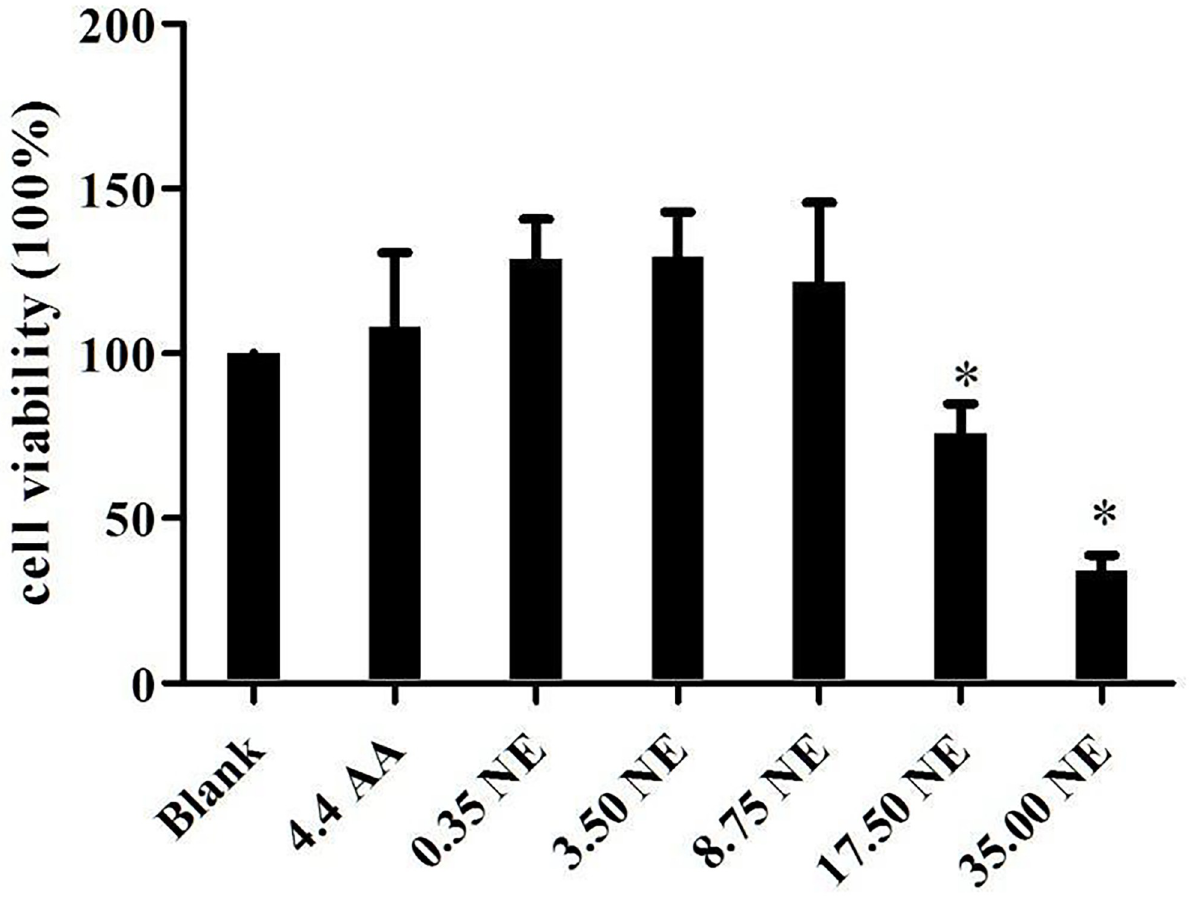
Fig 1. Cell viability of keratinocytes cells after different treatments. Notes: Blank = untreated samples; AA = Ascorbic acid; NE = Nanoemulsions; All concentration is in μ g/mL. ( � ) Means significant differences found when compared to the blank.